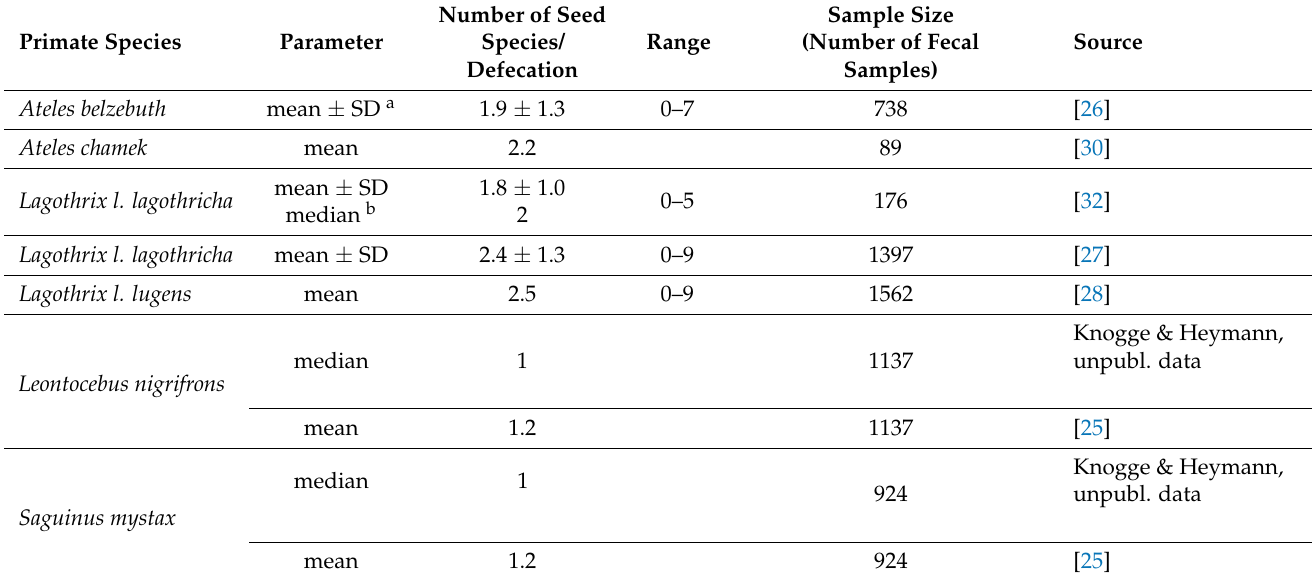
Table 3. Number of seed species per defecation.